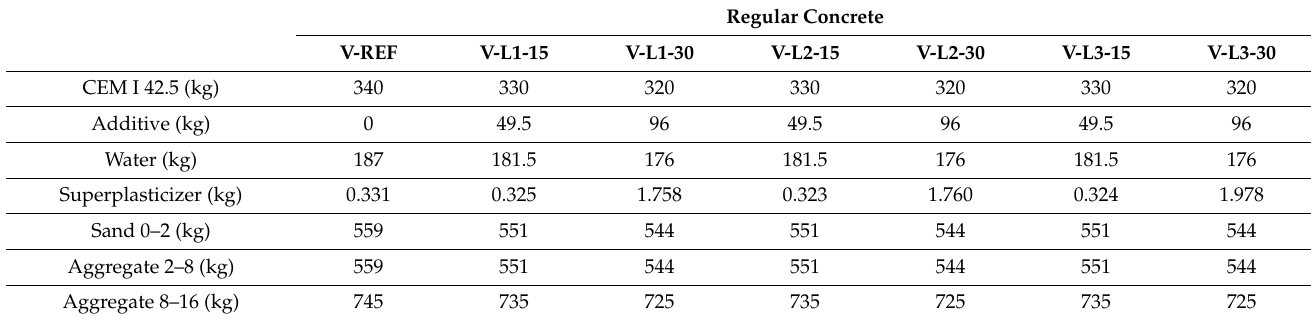
Table 2. Composition of 1 m 3 of vibrated concrete with no air-entraining admixture.